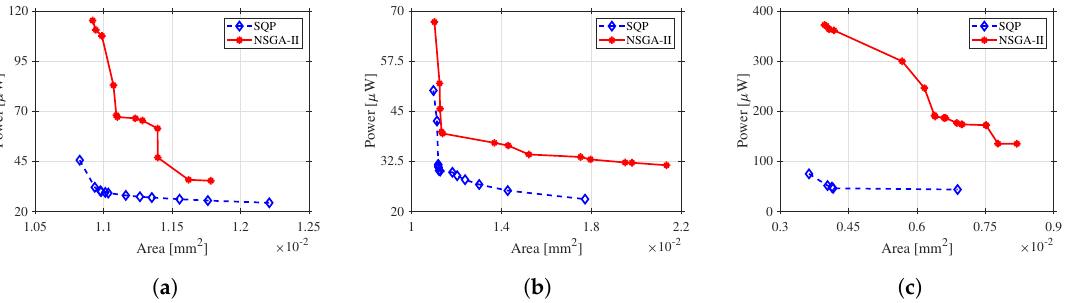
Figure 6. Pareto front of the optimization of filter ( FC = 100 KHz) using SQP and NSGA-II optimization algorithms in ( a ) TSMC 180 nm CMOS process. ( b ) IBM 130 nm CMOS process. ( c ) TSMC 65 nm CMOS